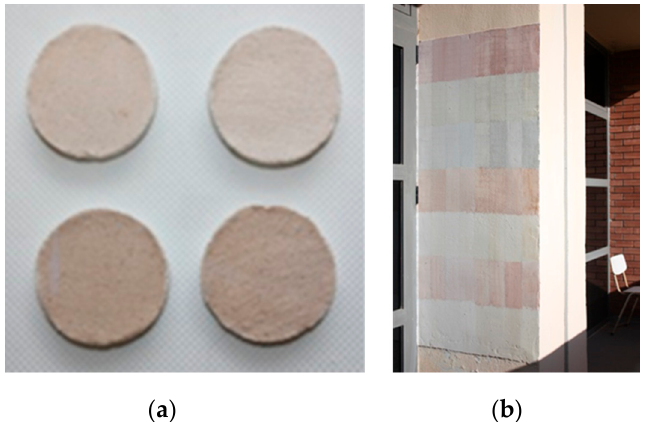
Figure 3. Type of specimens for the laboratory analyses ( a ) biscuits, ( b ) exterior wall surface.